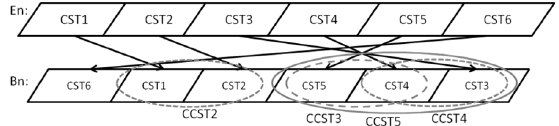
Table 3. For example, [CST6 CST1 CST2 CST5 CST4